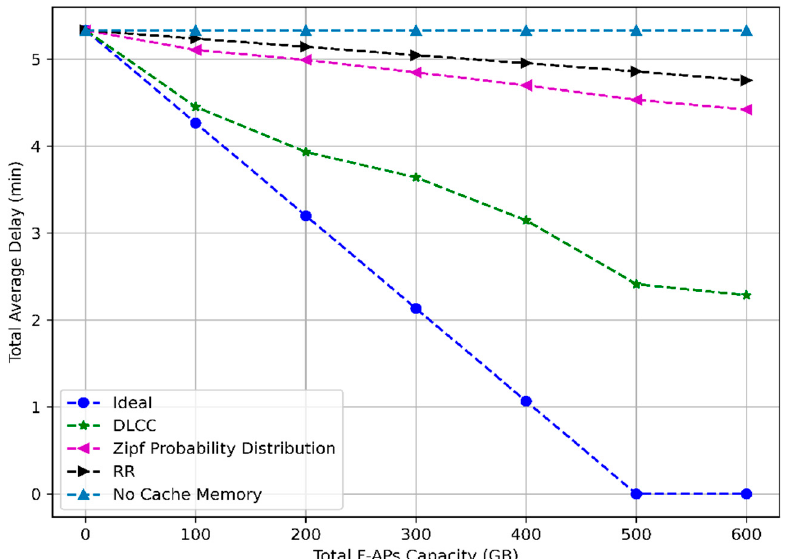
Figure 13. Total F-AP capacity vs. total system delay